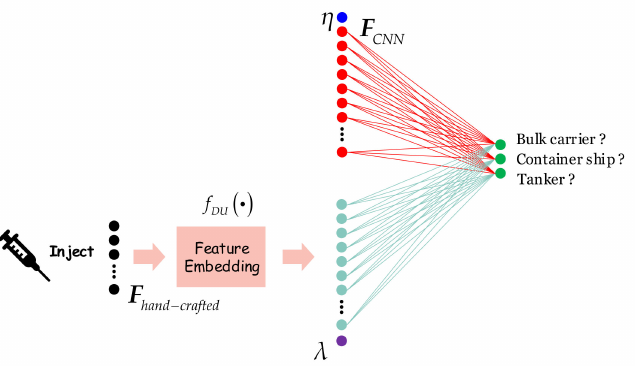
Figure 17. Diagrammatic sketch of the dimension unification weighted concatenation